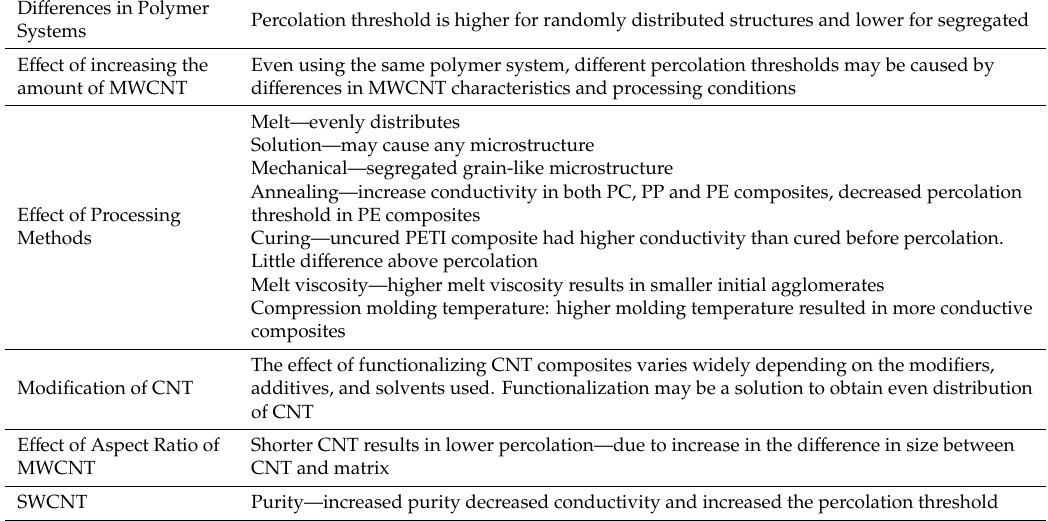
Table 2. Summary of Trends for MWCNT Polymer Composites.